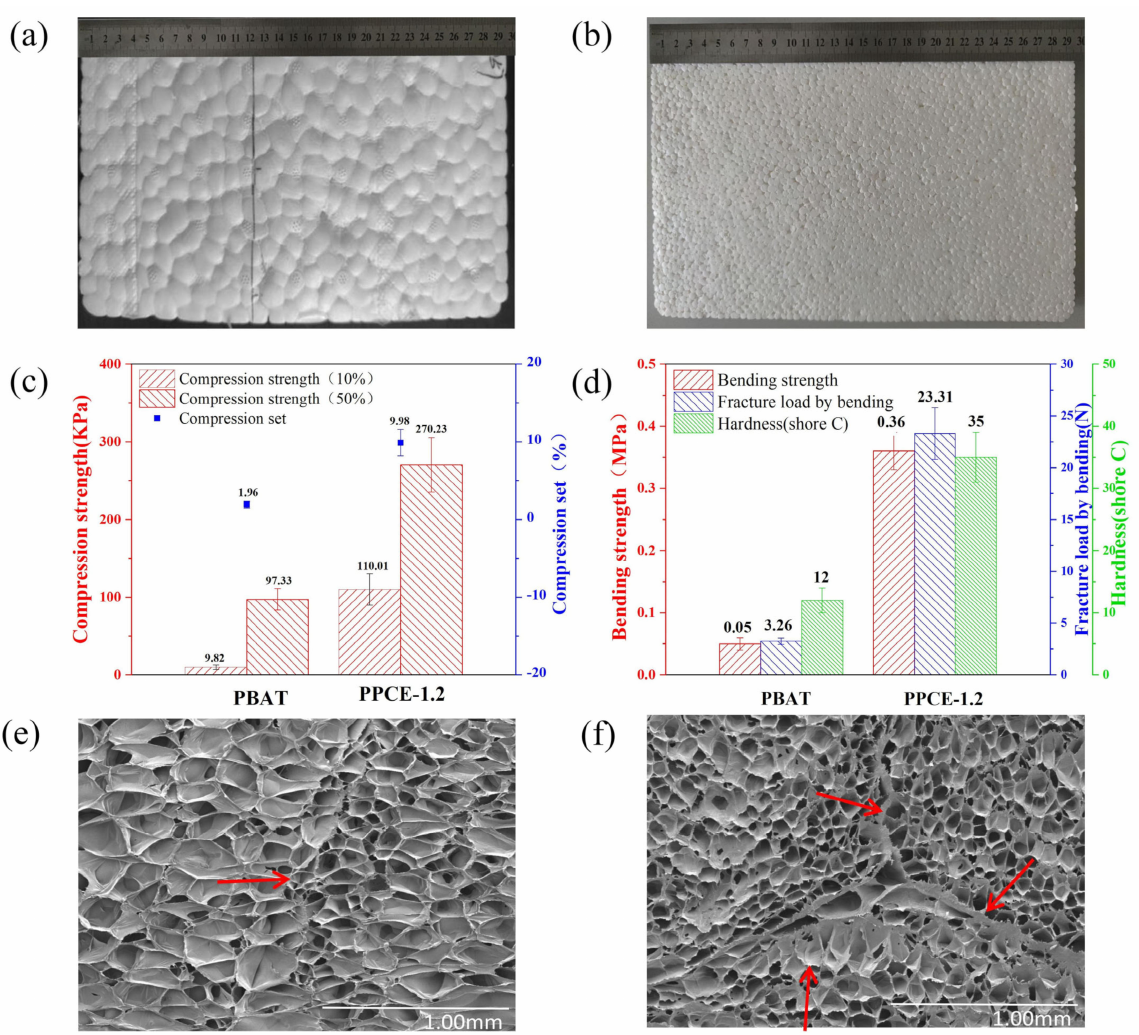
Figure 8. ( a ) PBAT foam-forming sheets and ( b ) PPCE-1.2 foam-forming sheets. Characterization of PBAT and PPCE-1.2: ( c ) compression properties, ( d ) bending properties and hardness (shore C). ( e ) SEM image of PBAT foaming particle-bonding position. ( f ) SEM image of PPCE-1.2 foaming particle-bonding